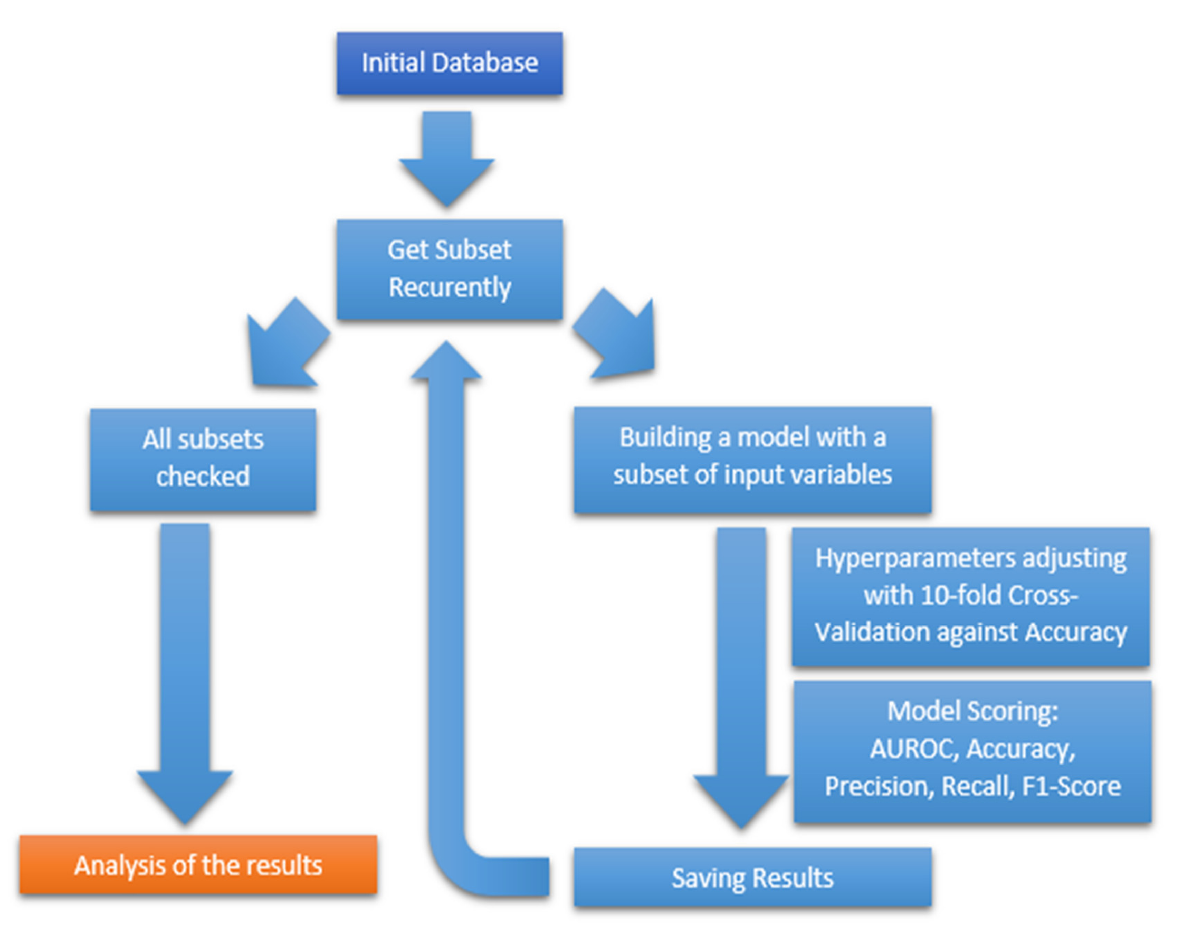
Figure 1. The database is divided into a training and testing set. The training set is the initial database from which we recursively removed the columns, thus changing the size of the input data vector (the number of input features). The model was then built and hyperparameters were adjusted. The performance was saved to a file for later analysis. The analyzed subsets have at least 2 input variables.